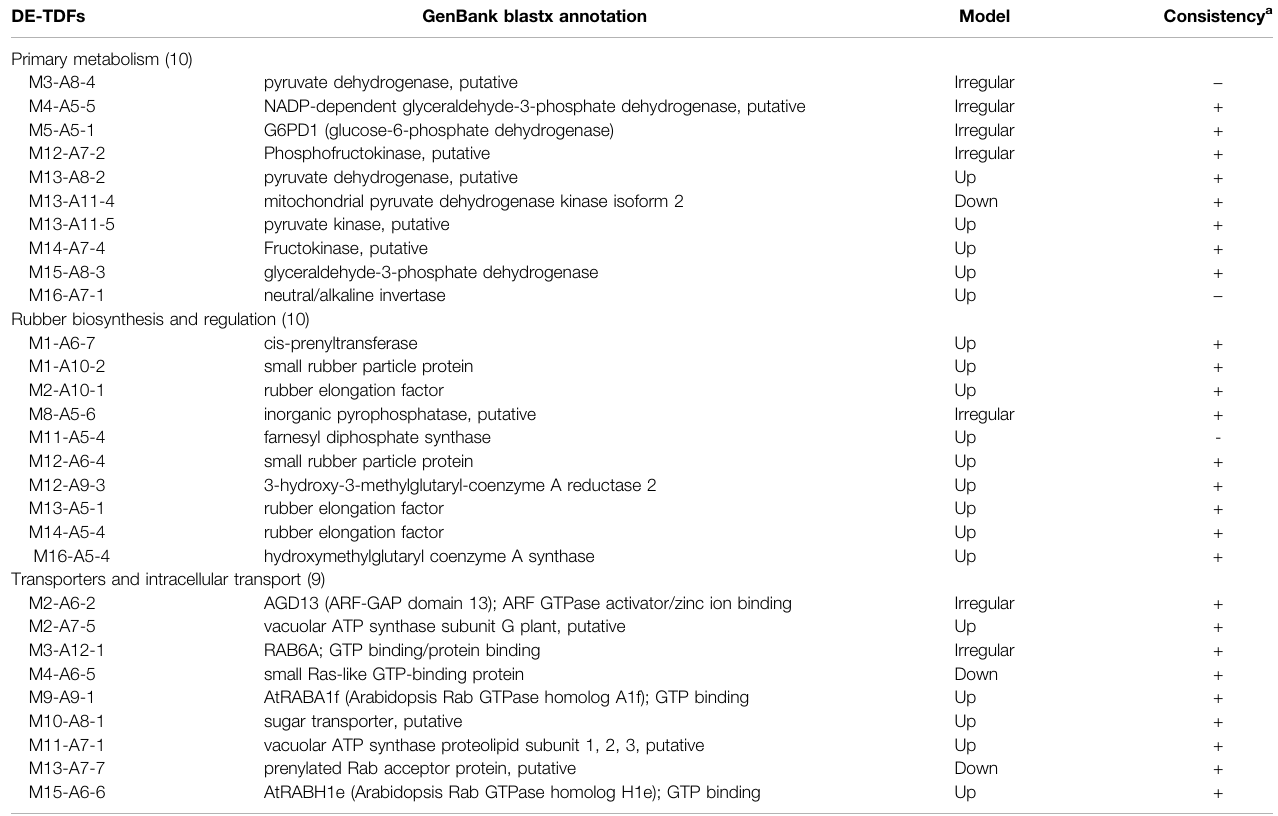
TABLE 3 | Information of latex regeneration related DE-TDFs for qRT-PCR analysis.